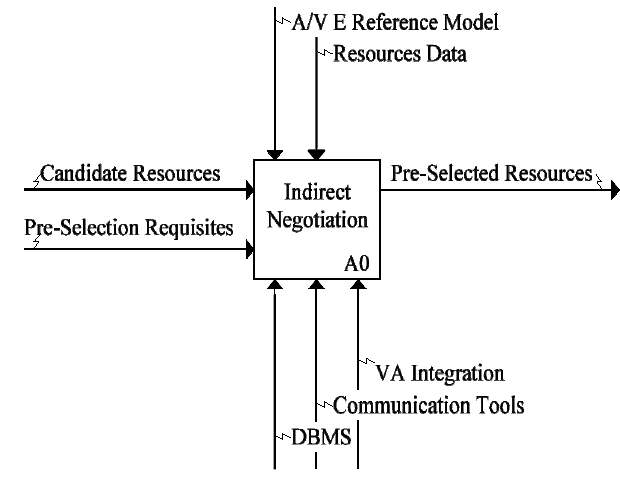
Figure 4. Representation of indirect negotiation with VA integration